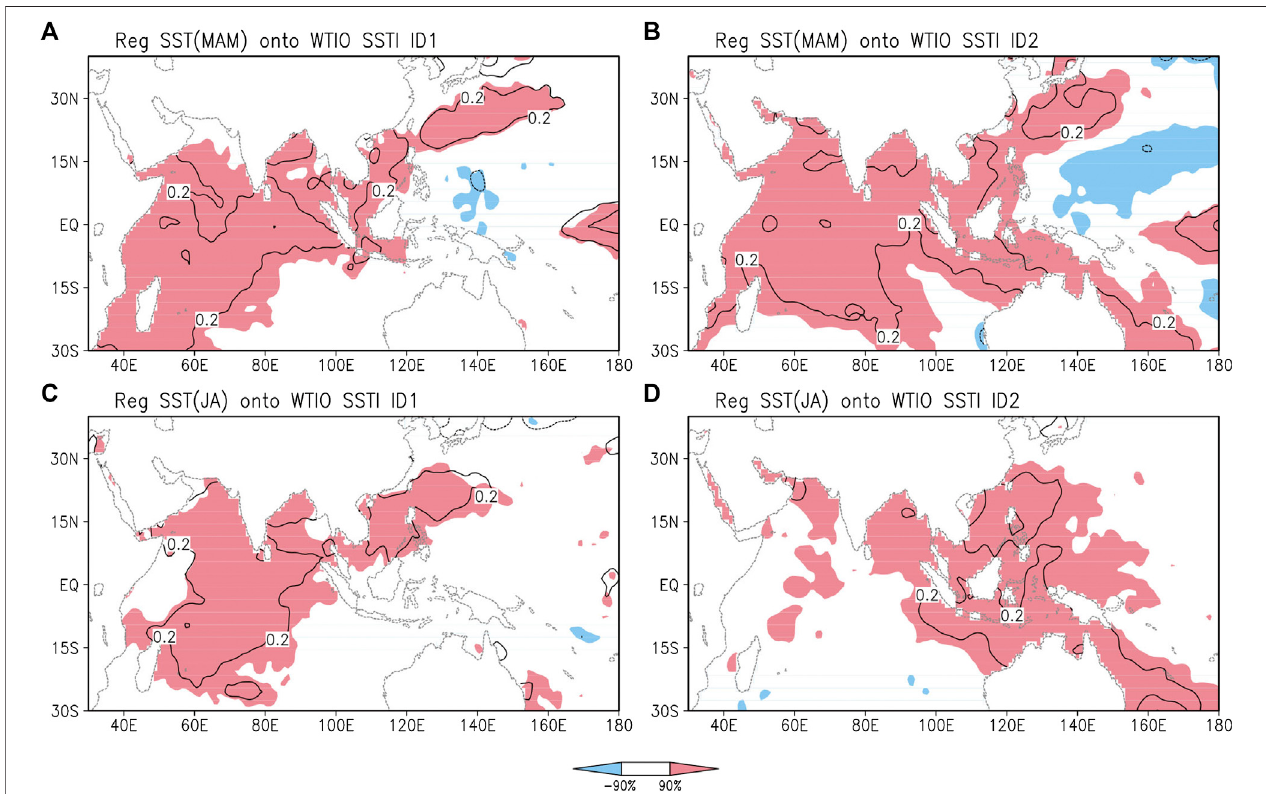
FIGURE7| Sameas Figure5 butfor (A,B) springand (C,D) summerSST(contour, ° C)in (A,C) ID1and (B,D) ID2.Areasthatsigni fi cantat90%con fi dencelevel are shading.